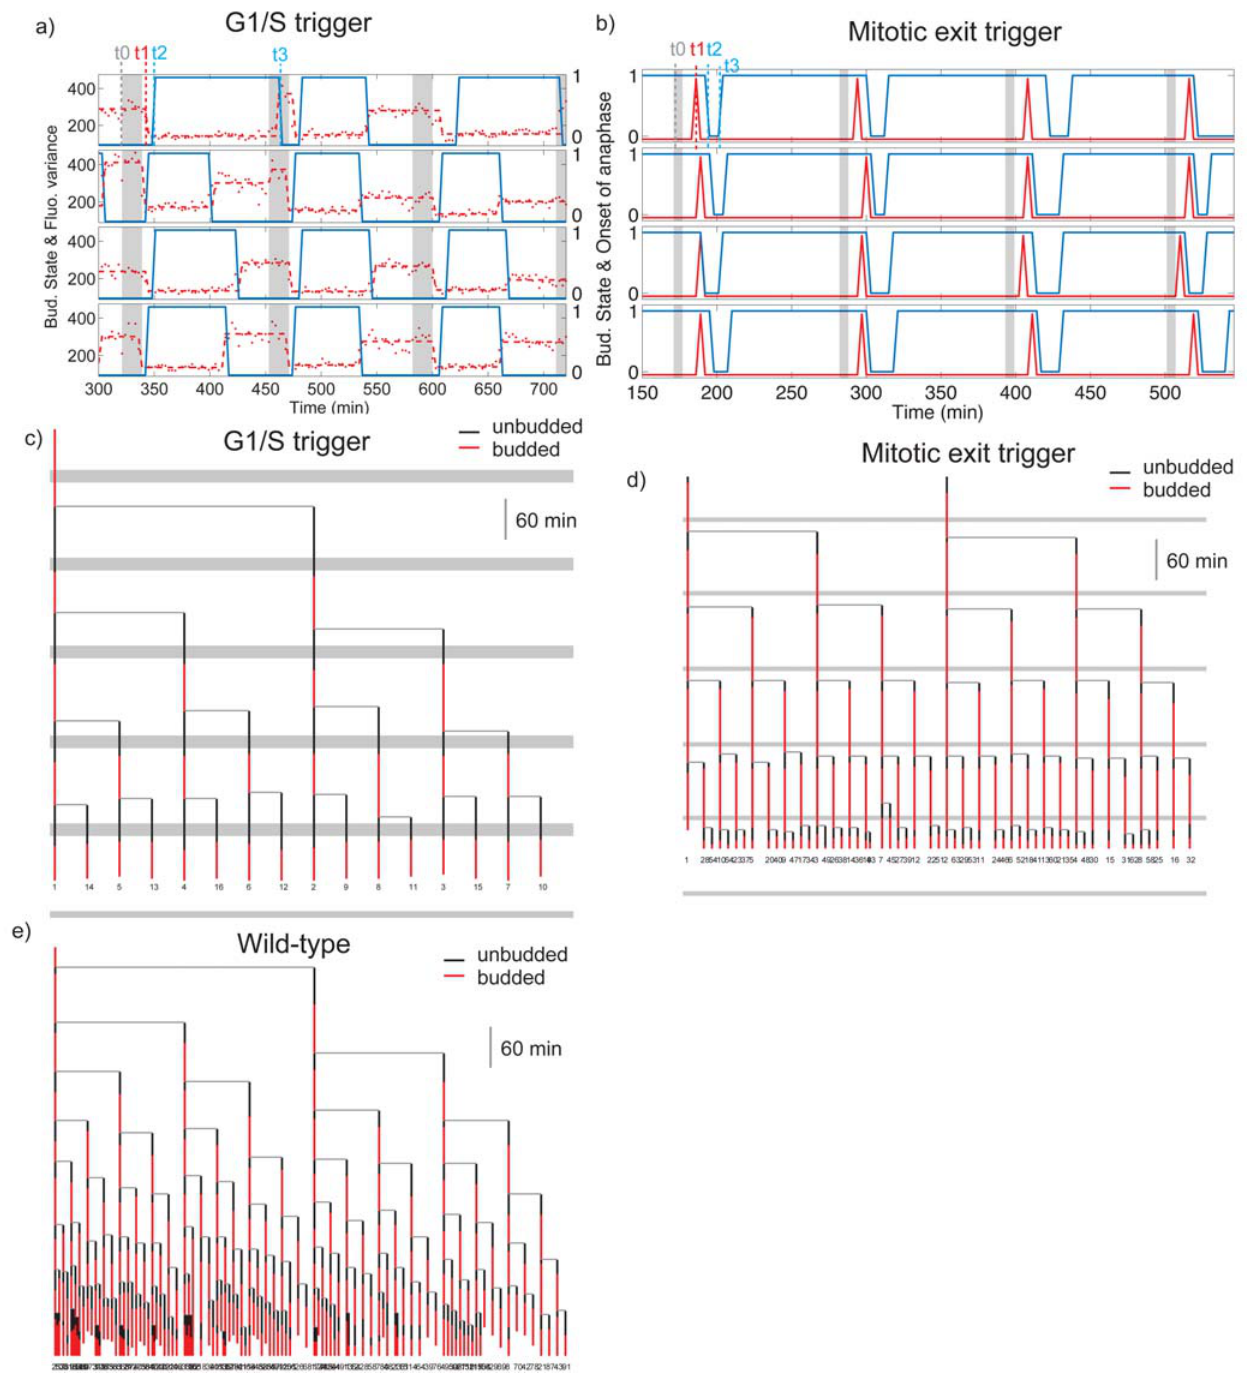
pulses of SCD + 0xMet. b) For the mitotic trigger, bud state is blue, the onset of anaphase is indicated in red, and the SCG pulse is the grey band. c-e) Phylogenies showing the budded/unbudded periods for all descendents of a founder cell, with pulsing bands overlayed where appropriate : c) the G1/S trigger; d) the mitotic exit trigger; e) WT cells.